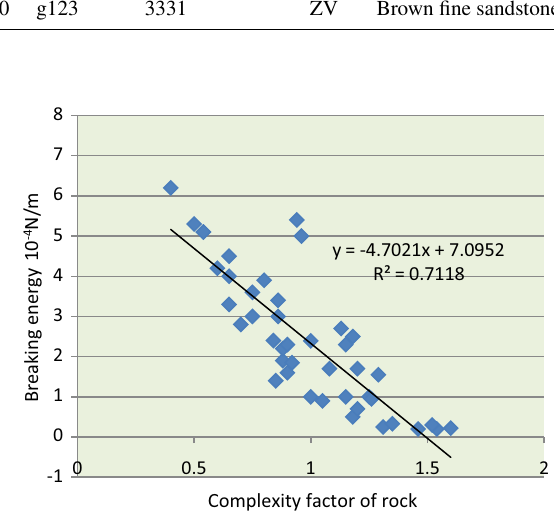
Fig. 4 Relationship between breaking energy and complexity factor of rock